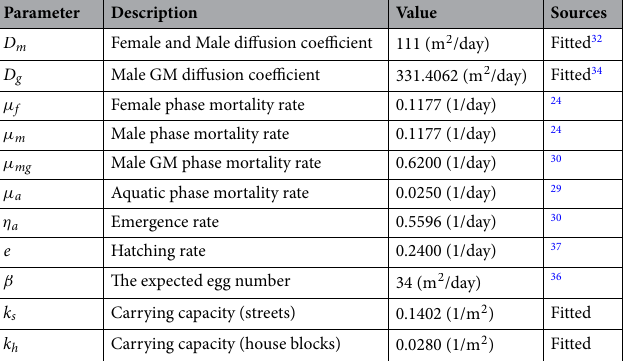
Table 1. All parameter values are directly taken or estimated from the literature as explained in section